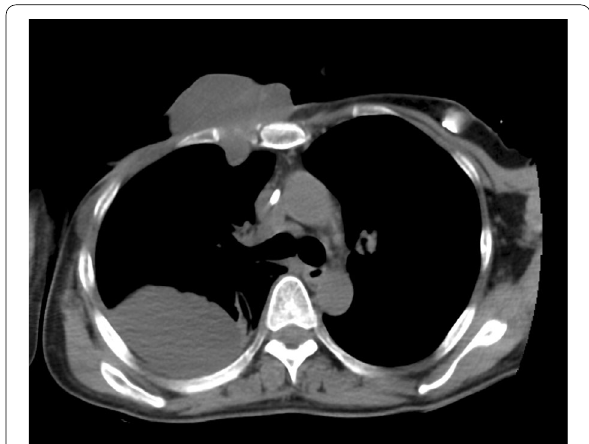
Fig. 5 Computed tomography revealed regrowth of tumor in the right chest, right lung and right pleural effusion